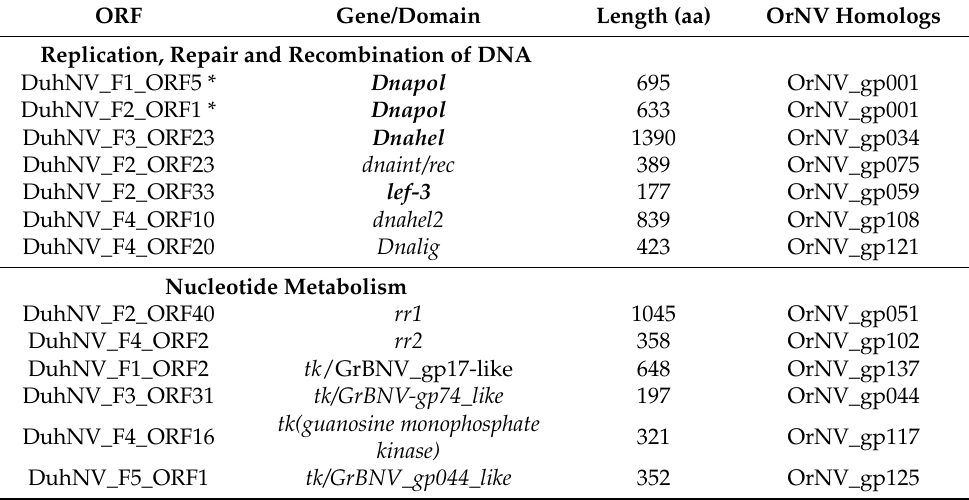
Figure 2. Putative arrangement of fragments F1–F2–F3–F4–F5 in the 147,179 bp assembled DuhNV genome sequence. Triangles represent sequence gaps. The putative genome schematic was generated by SnapGene Viewer v5.2.1. Table 4. Putative genes of Diabrotica undecimpunctata howardi nudivirus